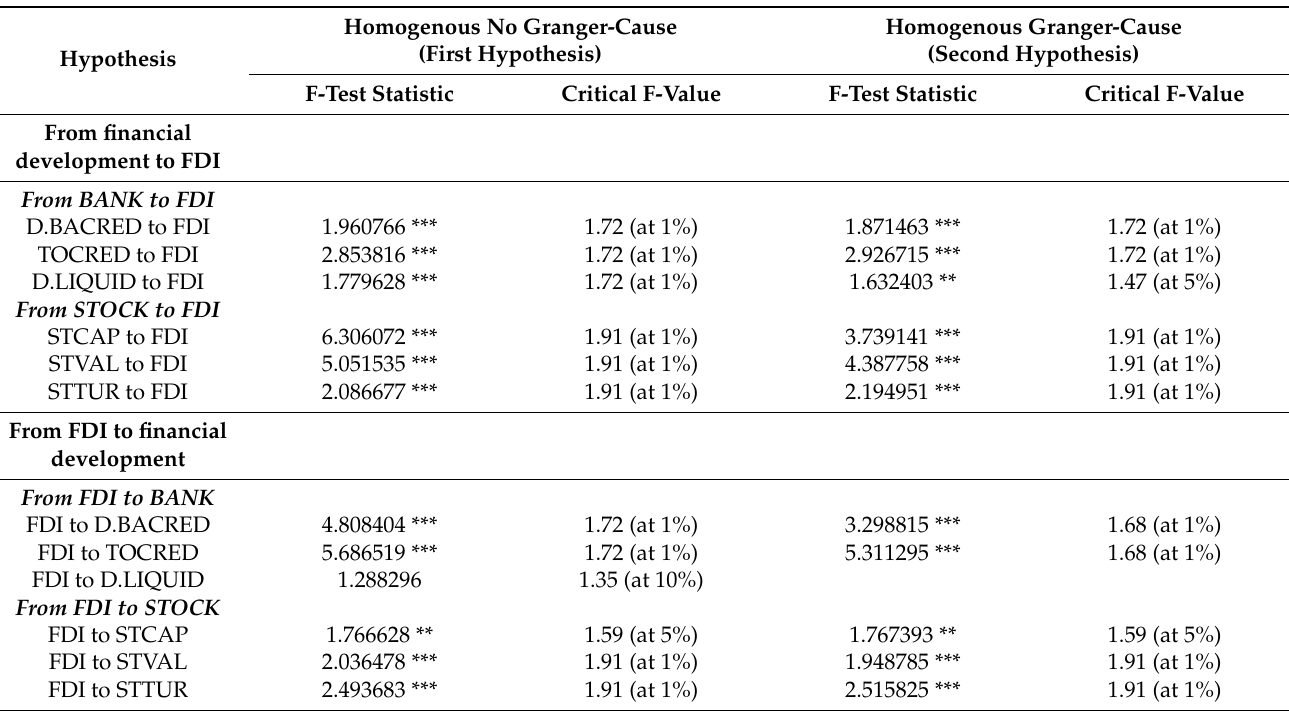
Table 4. The Granger causality test